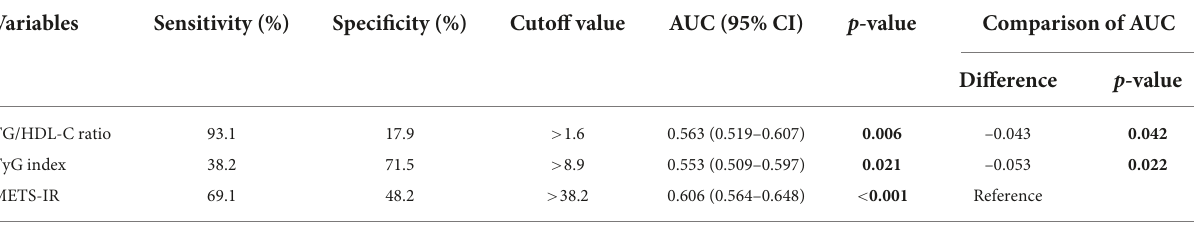
TABLE 7 Comparison of the predictive value of the TG/HDL-C ratio, TyG index, and METS-IR for predicting high GS. Variables Sensitivity (%) Specificity (%) Cutoff value AUC (95% CI) p -value Comparison of AUC